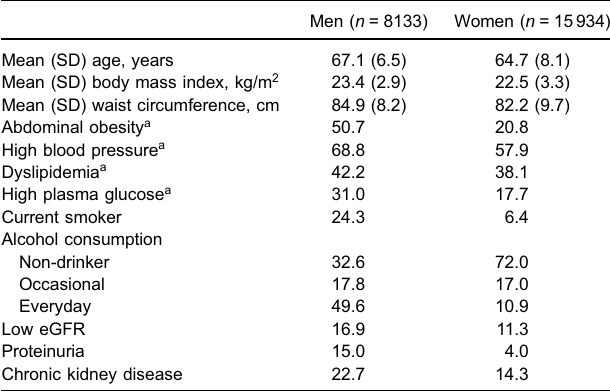
Table 1. Characteristics of study participants